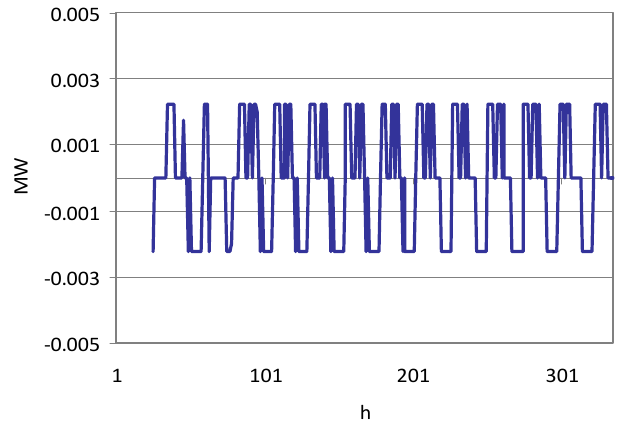
Figure 10. P course along 14 days obtained—stable scenario. batt